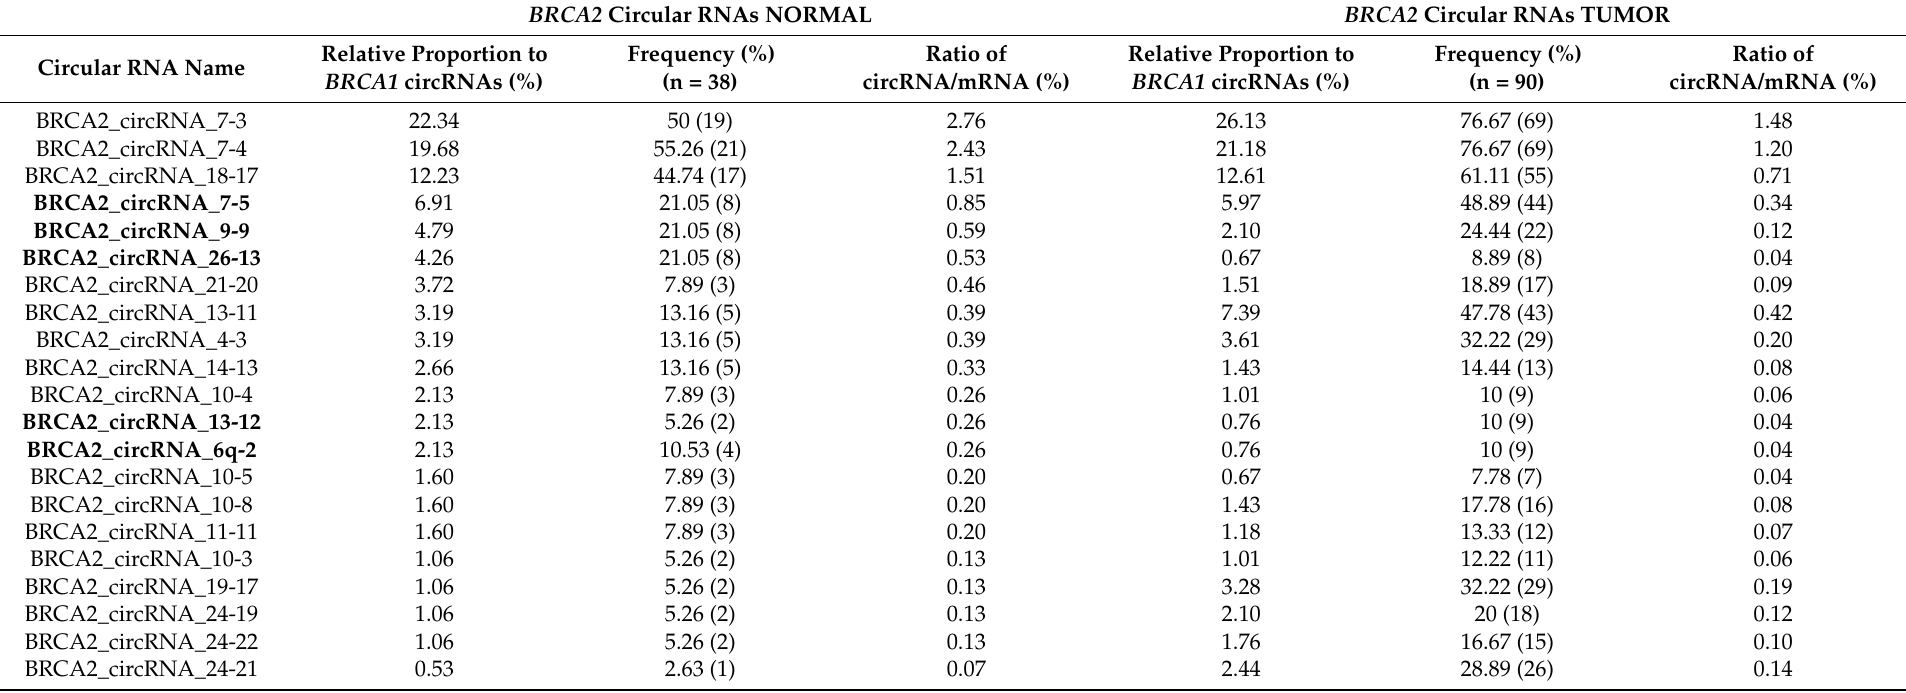
Table 2. The 20 most represented and novel BRCA2 circular RNAs in the normal and tumor breast tissue samples of the research set. Twenty-one circRNAs are listed, as circRNA22-15 is among the 20 most represented in the tumor tissue samples, but not in the normal tissue samples. Conversely, 5q-3 is among the 20 most commonly represented circRNAs in the normal tissue, but not in the tumor tissue samples. The novel circRNAs are indicated in bold. BRCA2 Circular RNAs NORMAL BRCA2 Circular RNAs